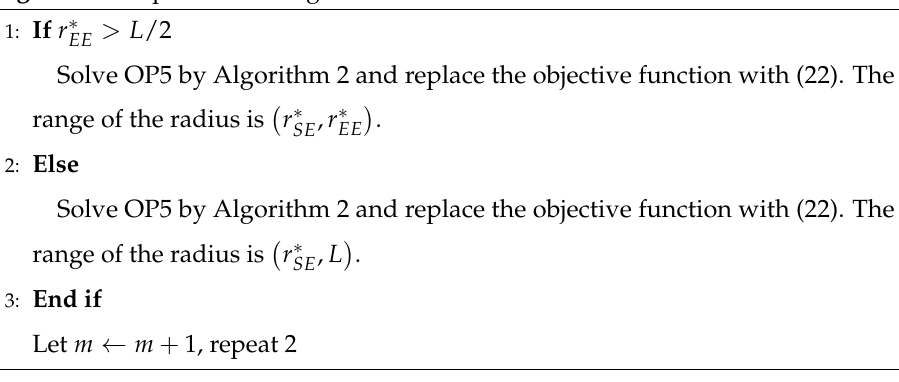
Algorithm 3 Optimization algorithm for the trade-off between EE and